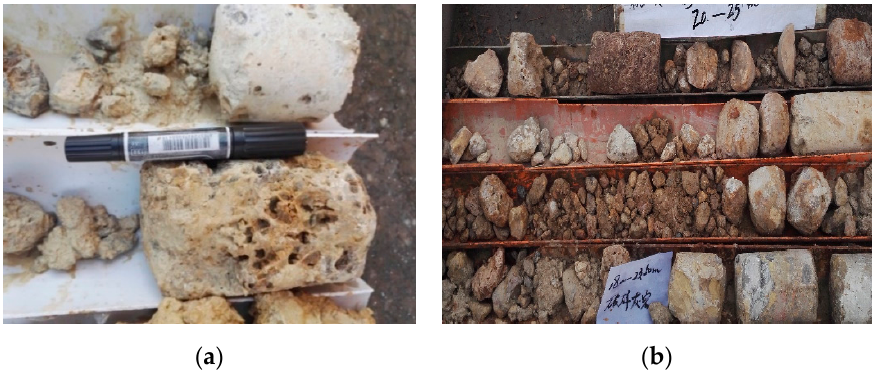
Figure 1. Dissolution limestone and limestone fragments. ( a ) dissolution limestone; ( b ) limestone fragments.